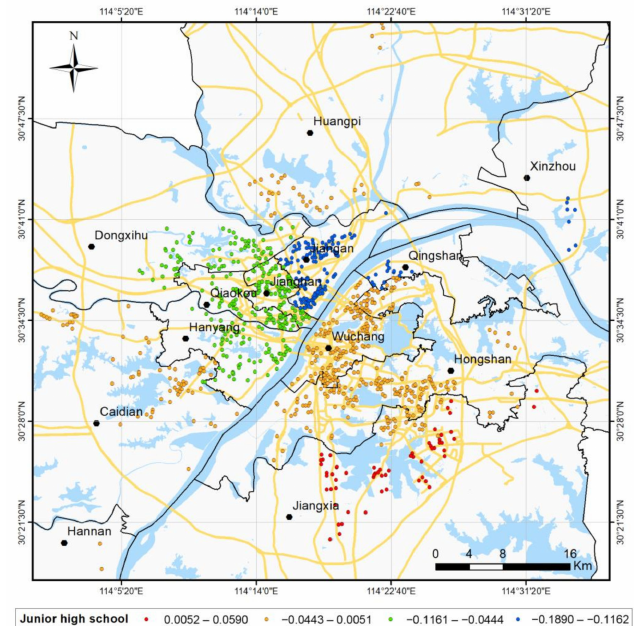
Figure 8. Junior high school coefficients map of the study area.